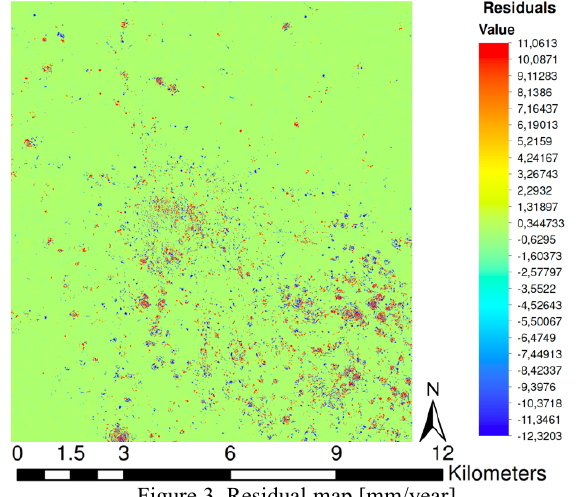
Figure 3. Residual map [mm/year]